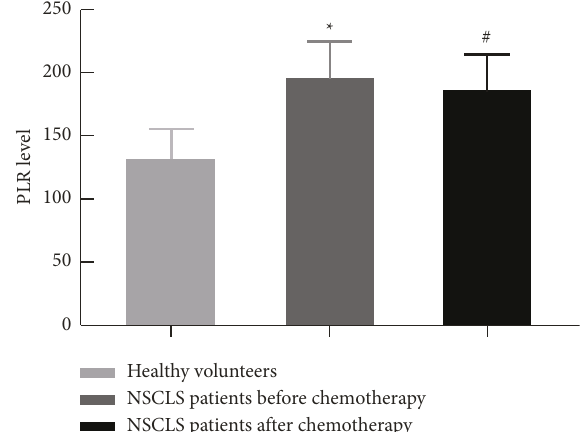
Figure 1: Comparison of PLR levels in patients with advanced NSCLC before and after chemotherapy and in healthy volunteers. Note. Compared with healthy volunteers, ∗ P < 0 . 05; compared with NSCLC patients before chemotherapy, # P < 0 .